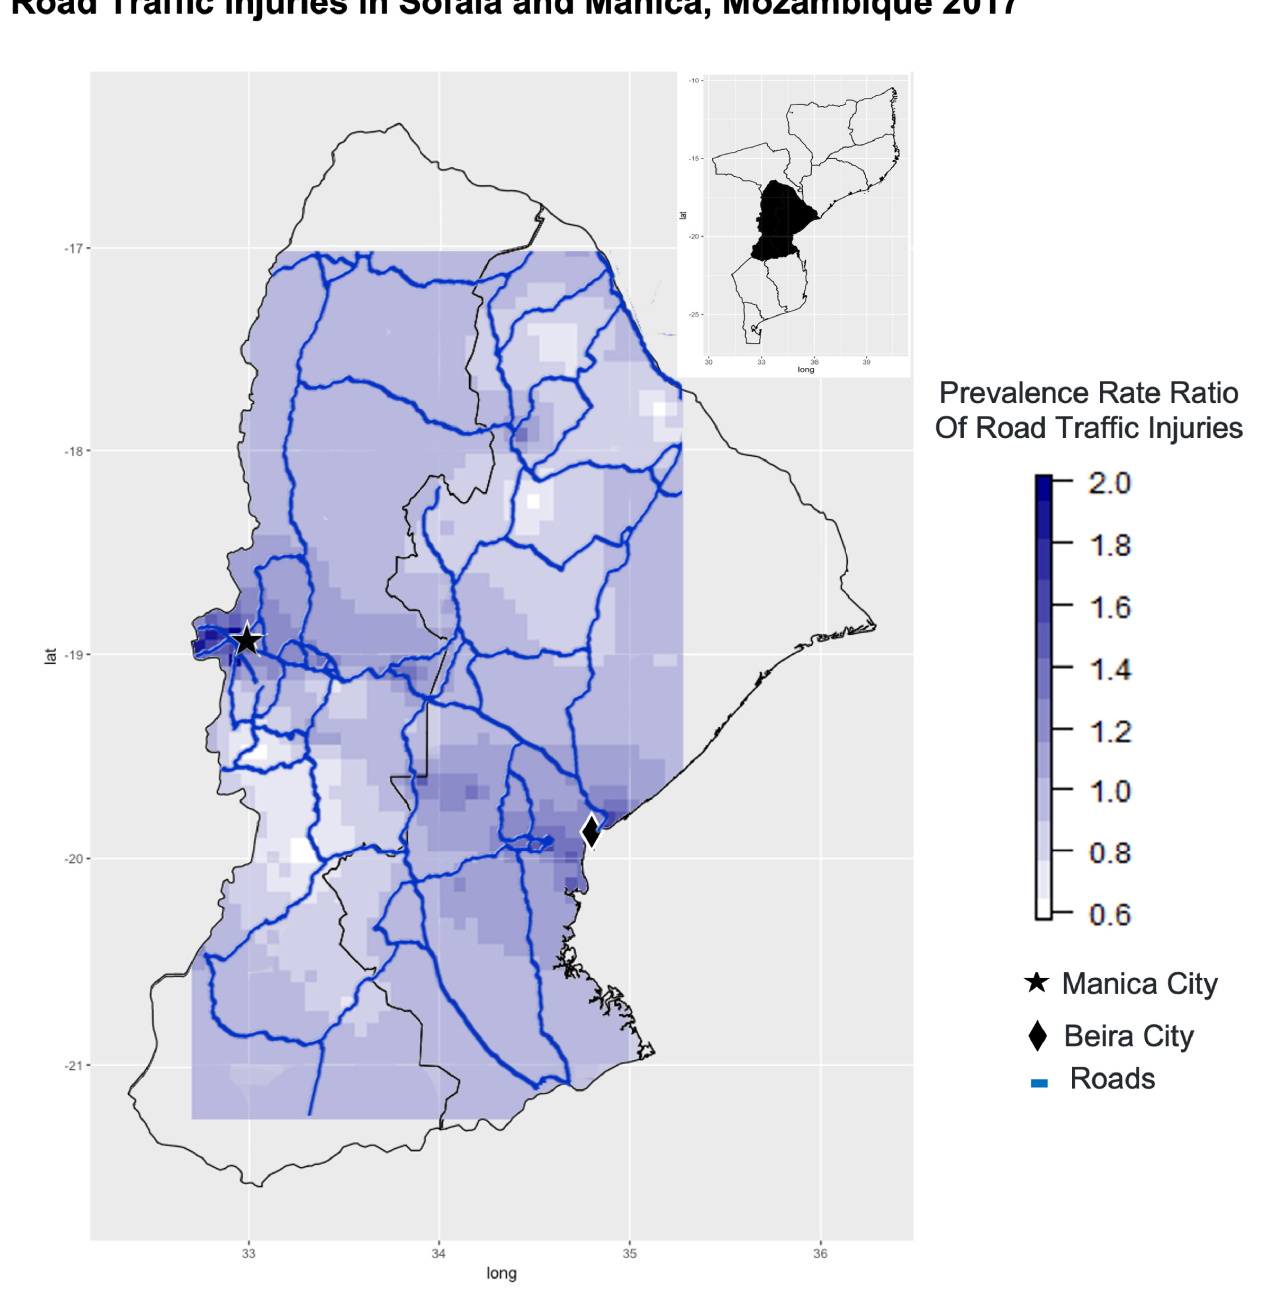
Fig 2. Map of prevalence rate ratio of road traffic injuries in Sofala and Manica, Mozambique 2017. We sourced United Nations maps for the Mozambique map, and World Bank maps for Mozambique roads. The maps were created in R using the packages tidyverse (ggplot2), sf, and Maps. To our best knowledge all the materials used are open